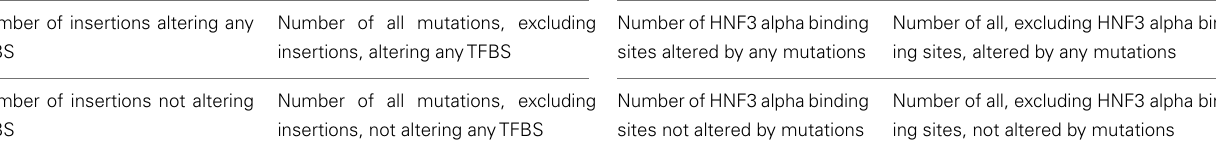
Table 3 | Example of contingency table for mutation type overrepresentation test.